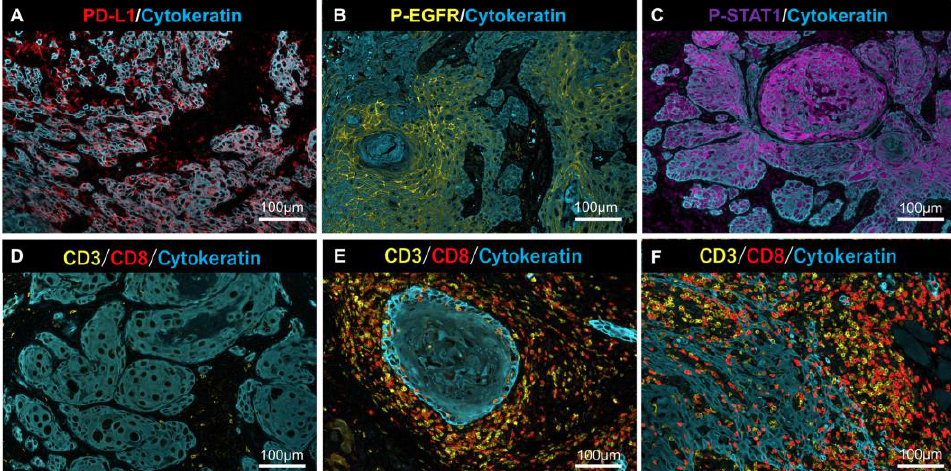
Figure 4. Representative MF-IHC staining results for PD-L1, p-EGFR, p-STAT1, and lymphocytes. Positive cases of PD-L1 ( A ), p-EGFR, ( B ) and p-STAT1 ( C ) in tumor cells. Representative case of ( D ) “Desert” (very few T-cells infiltrated into cancer tissues), ( E ) “Excluded” (T-cells infiltrated into stromal areas but not into the nest), and ( F ) “Inflamed” (T-cells infiltrated into the nest and stroma). Scale bars are indicated in each image.